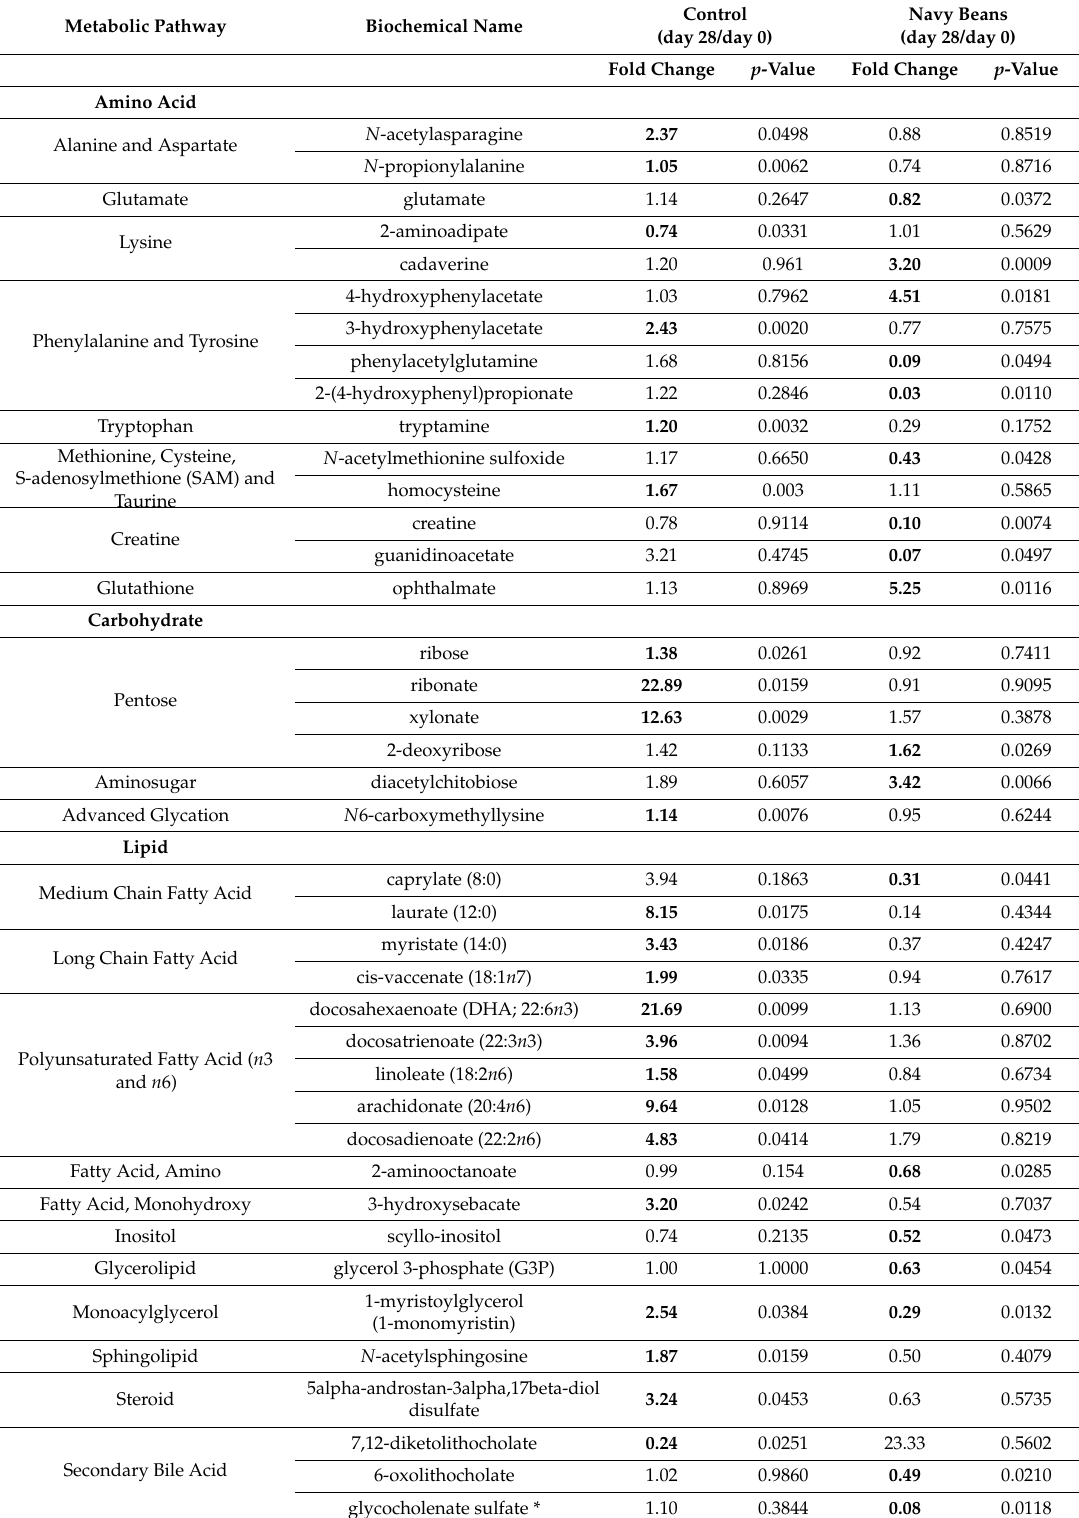
Table 2. Stool metabolites that change over time from participants consuming control or navy bean intervention meals and